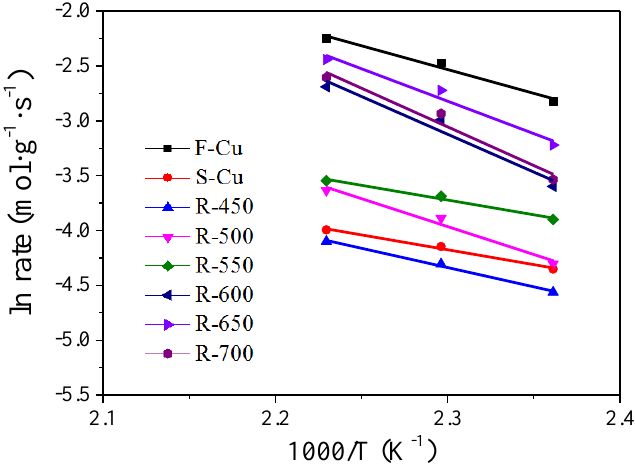
Figure 12. Arrhenius plots of the SCR reaction rates over Cu-SSZ-13 catalysts in fresh, sulfated and regenerated states.